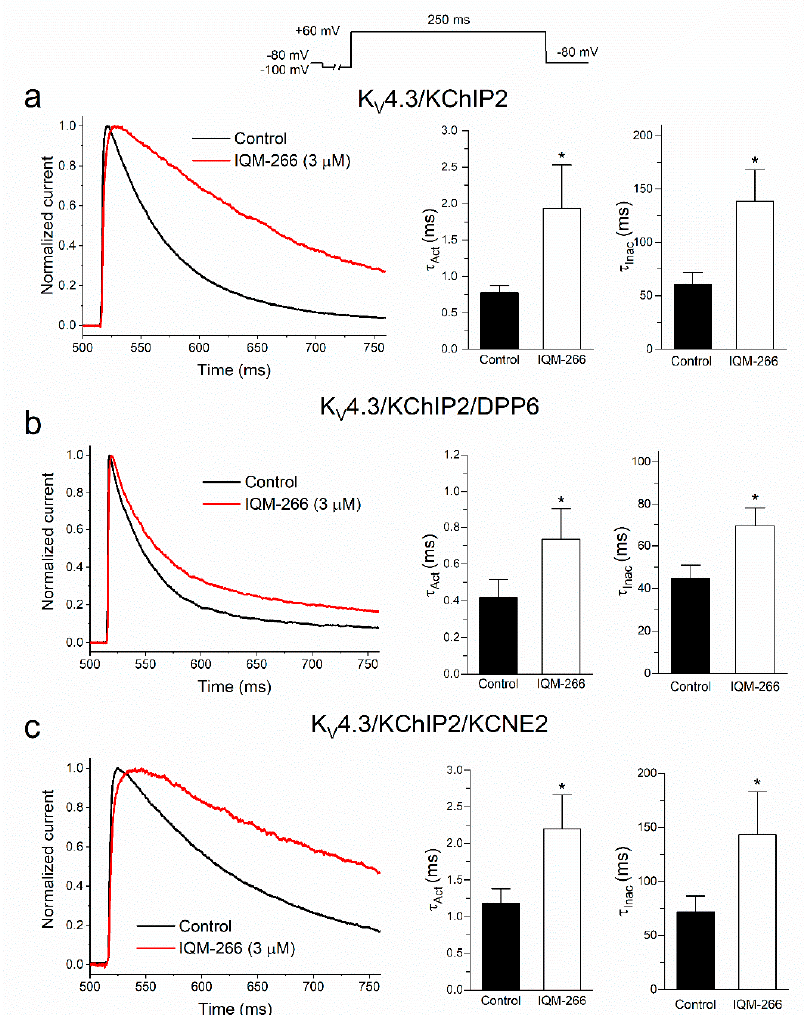
Figure 3. Activation and inactivation kinetics of K V 4.3/KChIP2 ( a ), K V 4.3/KChIP2/DPP6 ( b ) and K V 4.3/KChIP2/KCNE2 ( c ) currents in the absence and in the presence of IQM-266 (3 µM). Left panels show normalized current records under the three experimental conditions. These current records were fitted to a monoexponential equation in order to obtain the τ Act values. Middle panels show the histogram representing the τ Act under the different experimental conditions. Right panels show the histograms representing the τ Inac values under the three experimental conditions. Each bar represents the mean ± S.E.M. of n = 8 cells (from n = 5 transfections) for K V 4.3/KChIP2 channels, n = 8 (from n = 6 transfections) for K V 4.3/KChIP2/DPP6 channels and n = 10 (from n = 9 transfections) for K V 4.3/KChIP2/KCNE2 channels. *: p <